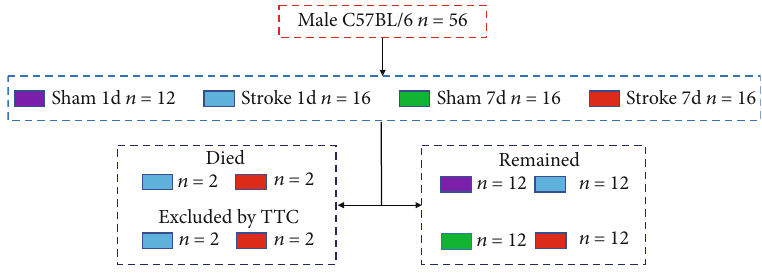
Figure 1: Animal grouping.